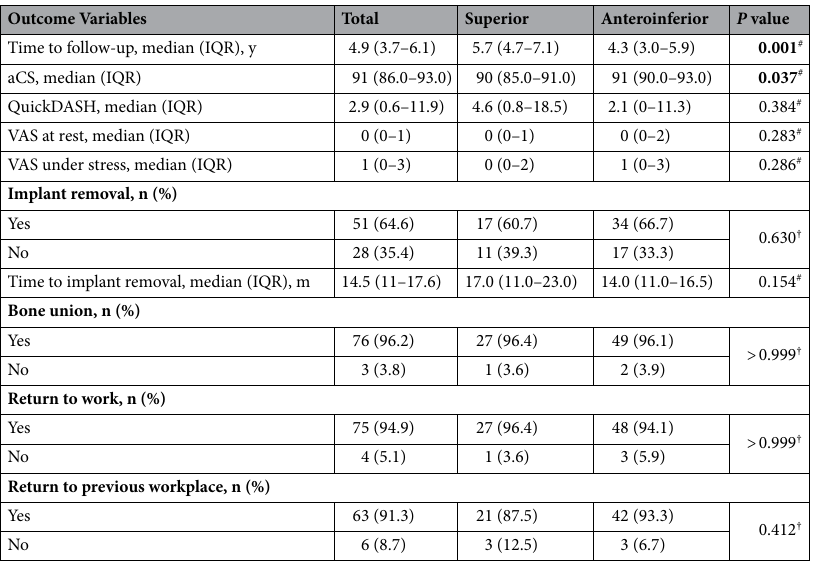
Table 3. Outcome variables. Significant values are written in bold text. aCS: adjusted Constant score, DASH: Disability of the Arm, Shoulder and Hand, IQR: Interquartile range, VAS: Visual Analog Scale, † : Fisher exact test, # : Mann–Whitney test.